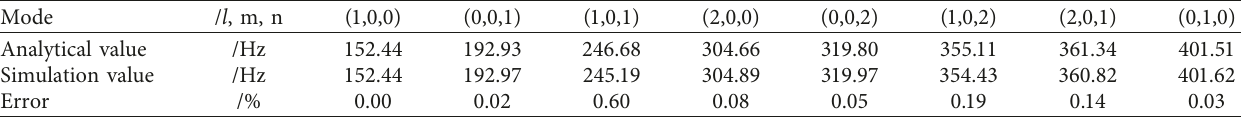
Table 2: Comparison of natural frequencies achieved with analytical method and simulation